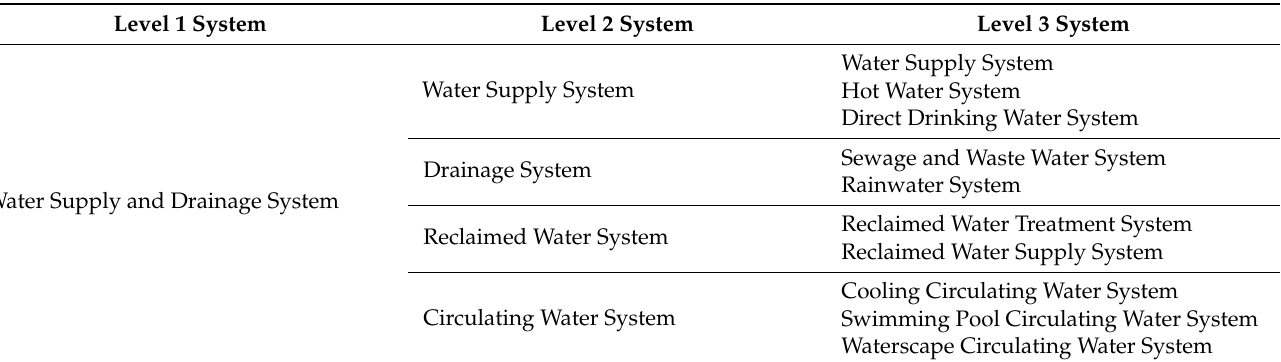
Table 1. MEP systems classification in China (part).